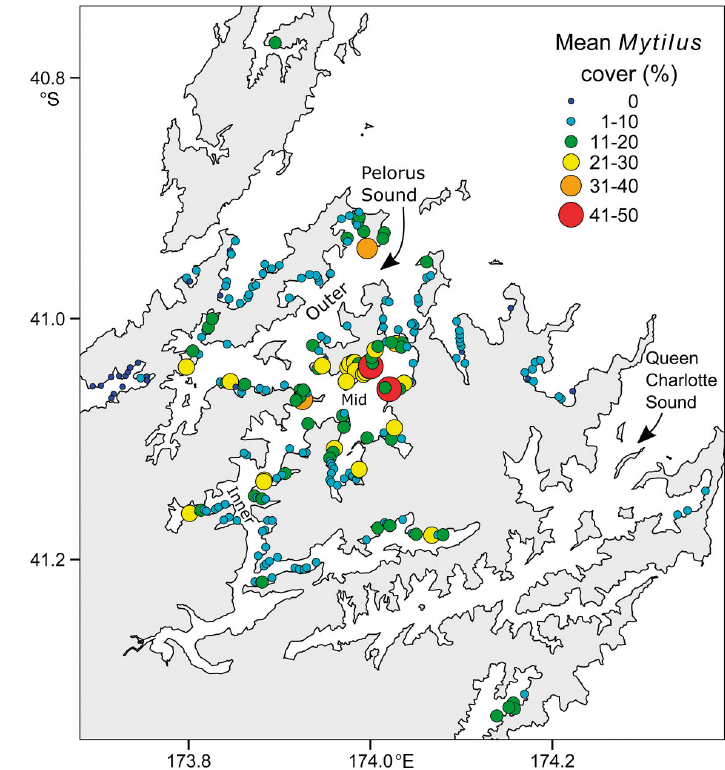
Fig. 2. Regional distribution of Mytilus galloprovincialis cover (%) in the Marlborough Sounds based on farm-averaged cover across multiple crops harvested from each of 243 mussel farm sites during 2012 to 2015. The main general areas of Pelorus Sound are indicated, including the worst affected locations (mid- and inner-) referred to in the text